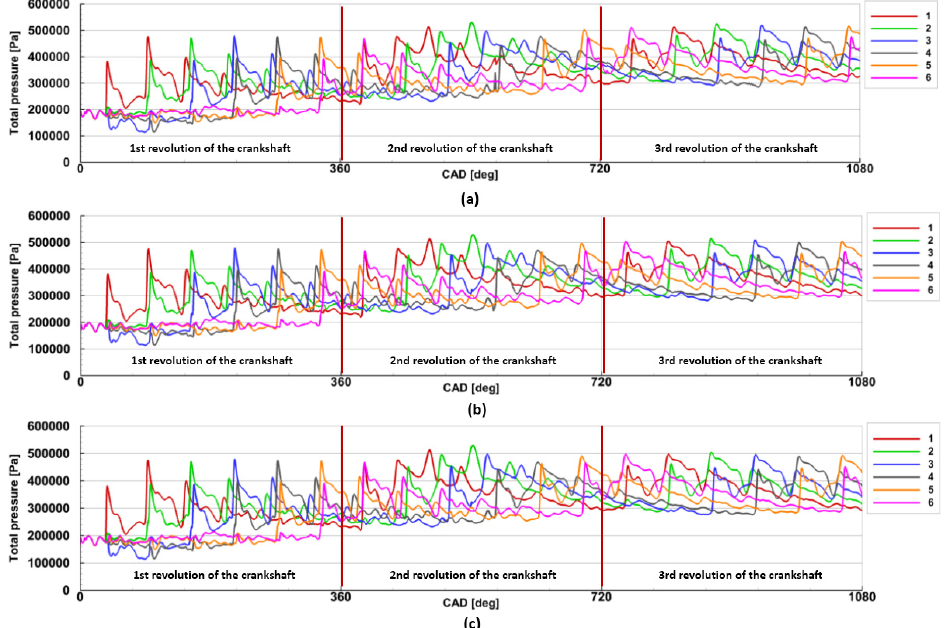
Figure 9. The plot of the total pressure at the 1-st stage turbine inlet for the 20° deg VTG opening at: ( a ) 60,000 rpm , ( b ) 50,000 rpm , ( c ) 40,000 rpm turbine speed.